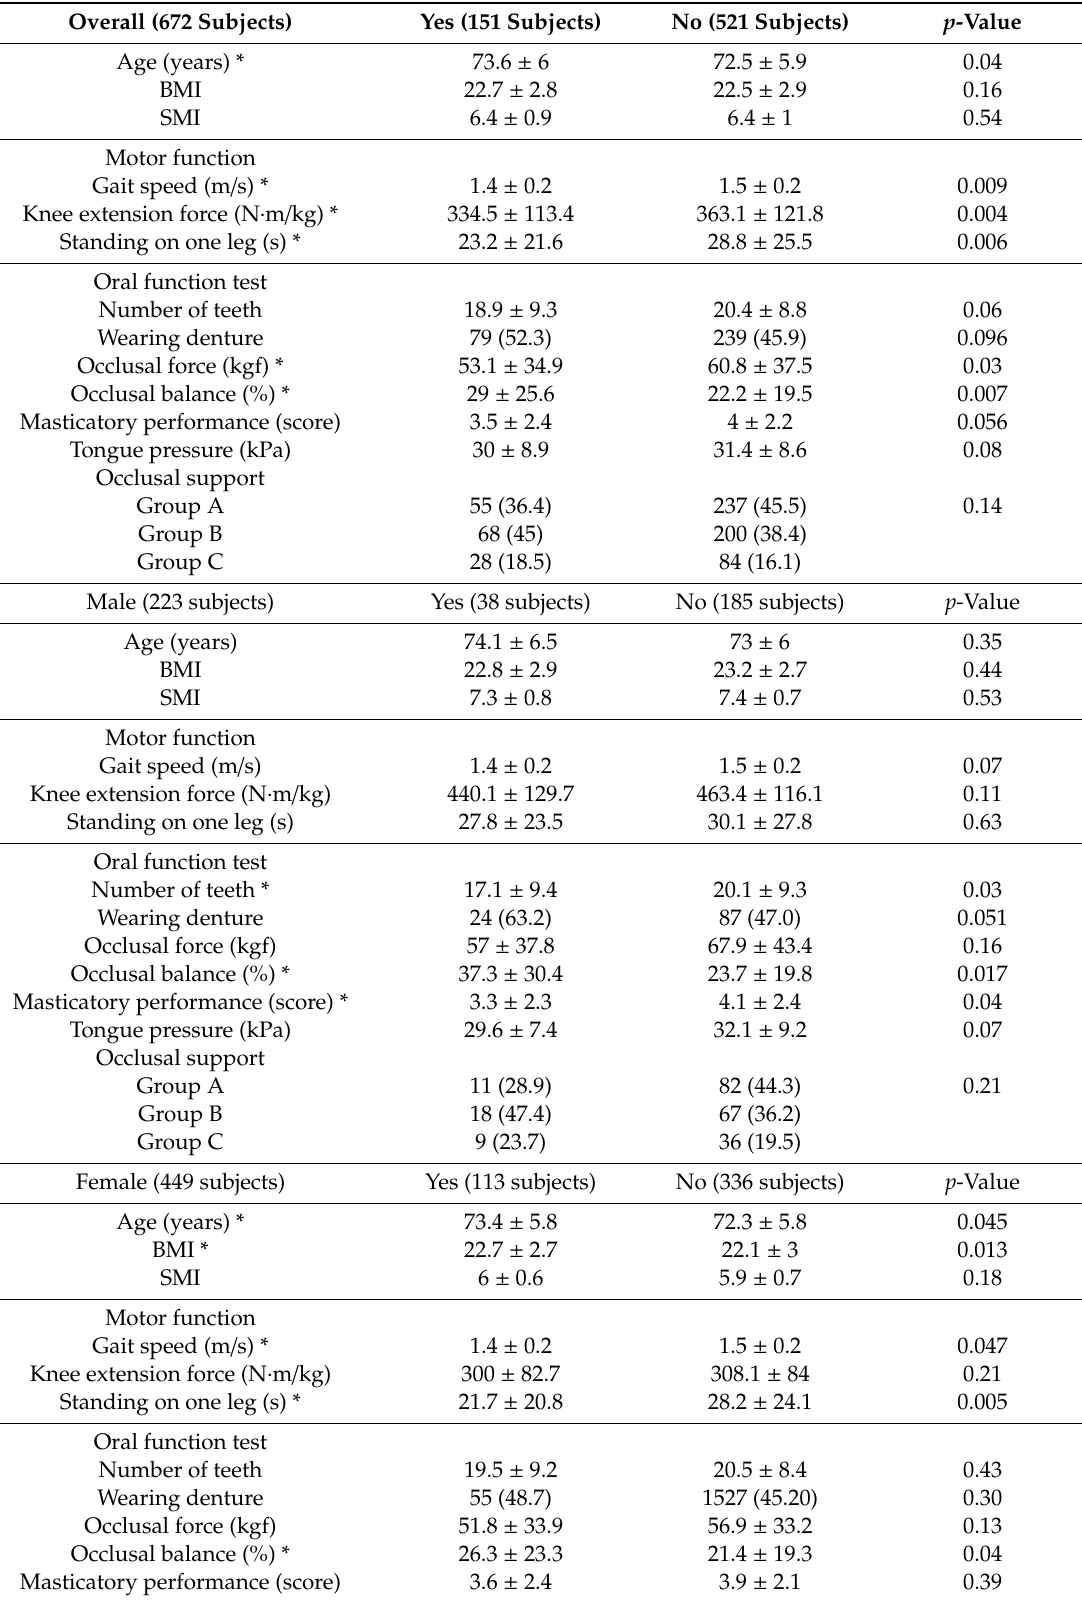
Table 3. The relationships between falling experience, motor function, and oral